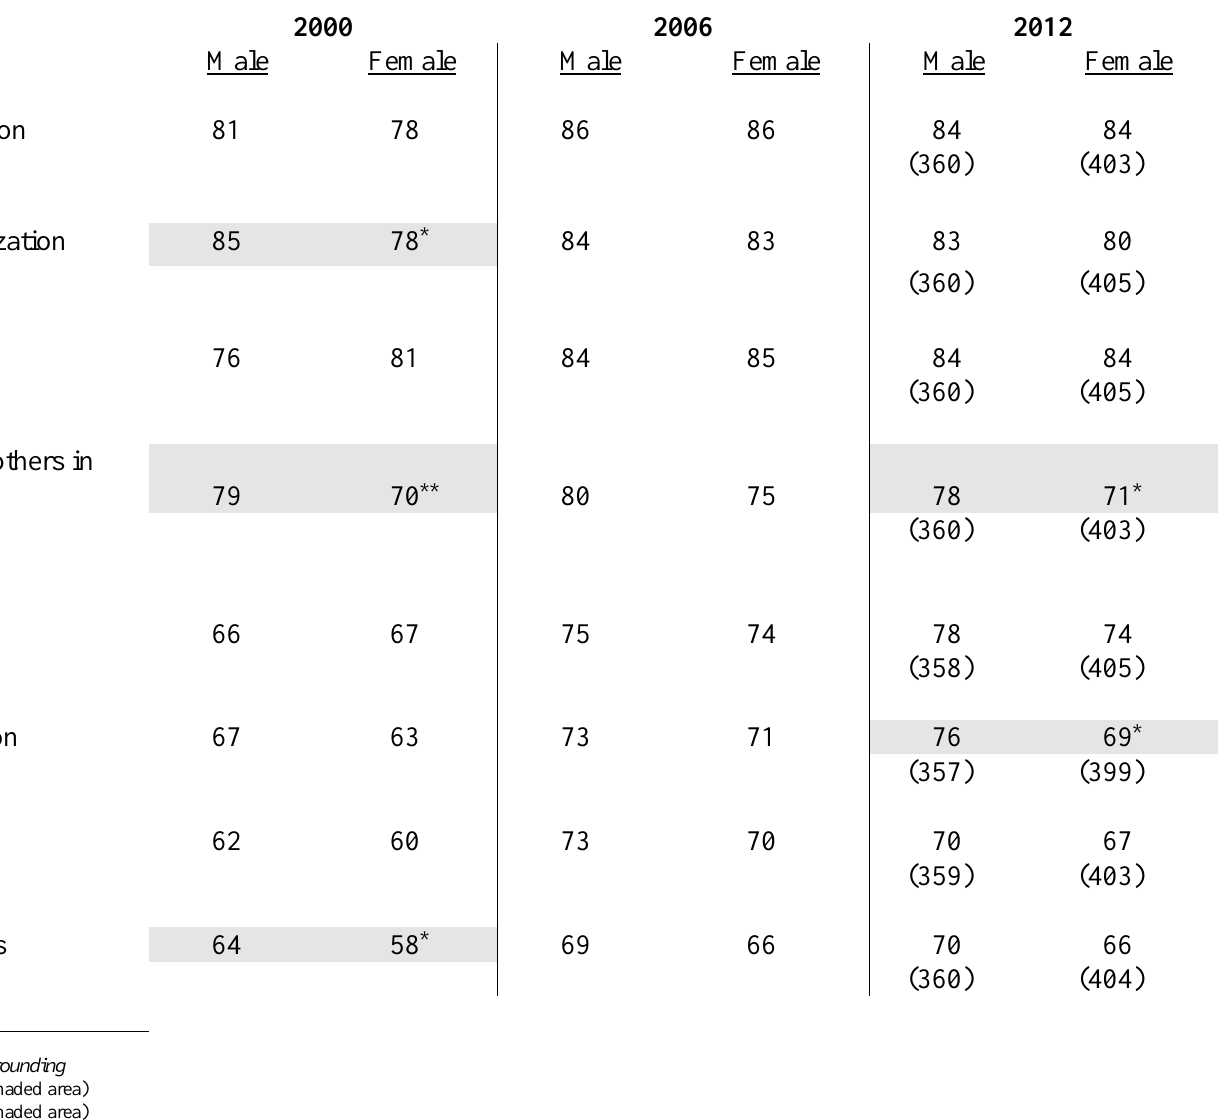
Table 10. Job Satisfaction (percent satisfied or very